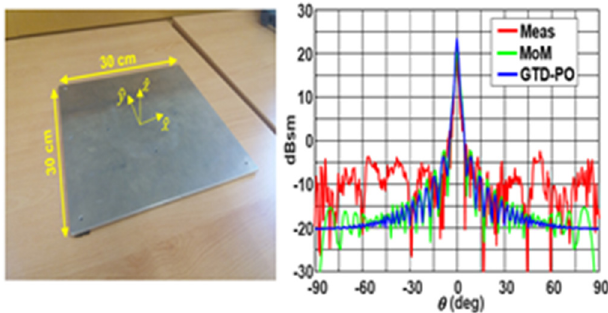
Figure 2. Metallic flat (30 × 30 cm 2 ). Monostatic radar cross section (RCS) results in